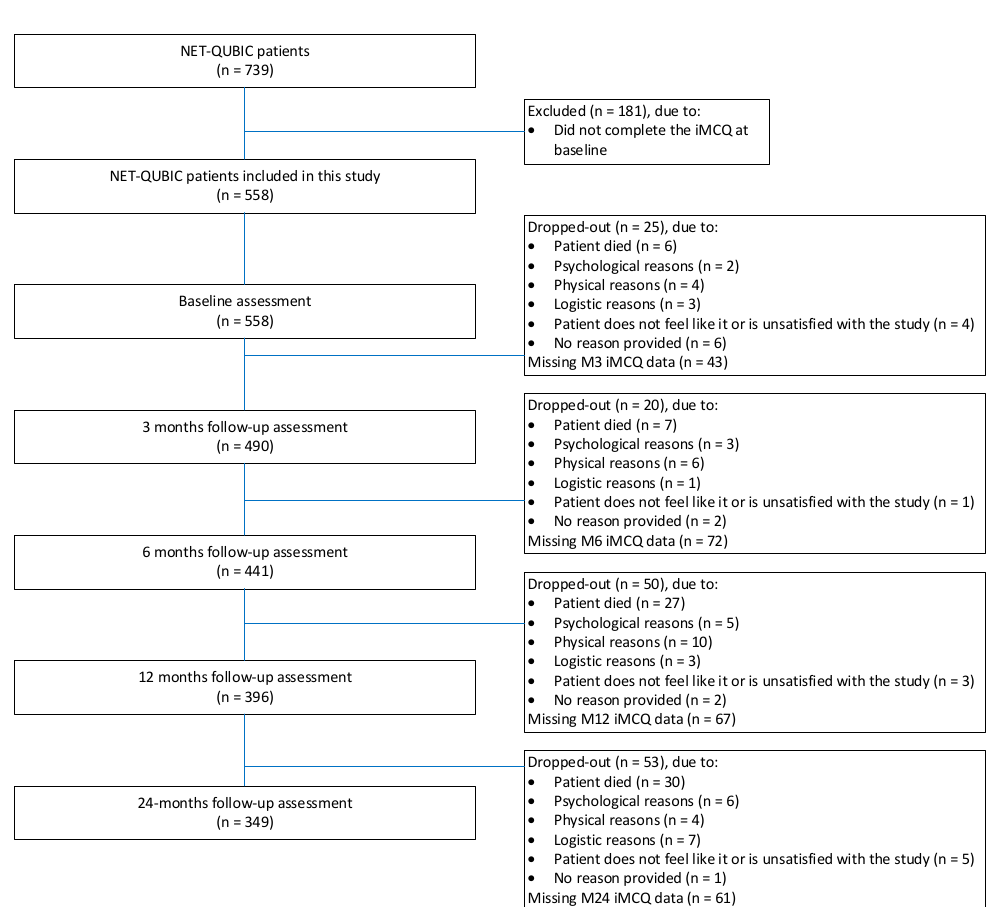
Figure 1. Medical consumption questionnaire (iMCQ). Figure 1. * Medical consumption questionnaire (iMCQ) Table 1. Characteristics of included and excluded patients.